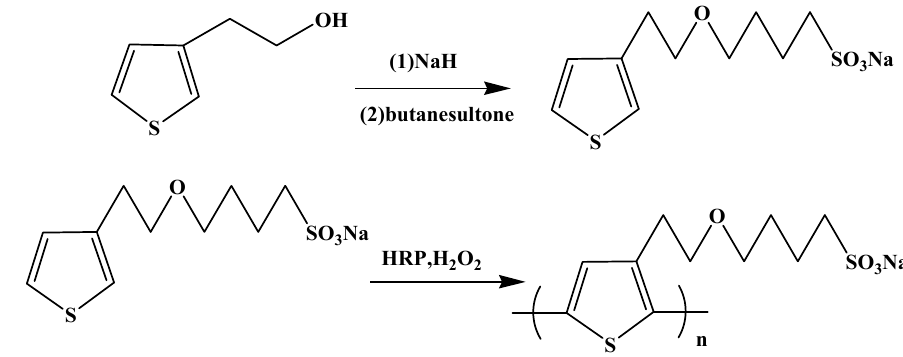
Figure 1. Scheme of enzyme-catalyzed polymerization of water-soluble (3-thienyl)-ethoxy-4- butylsulfonate (TEBS) with horseradish peroxidase (HRP).